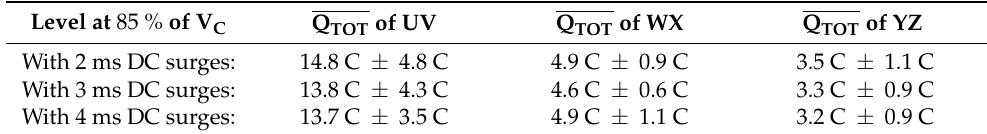
Table 10. Manufacturer durability comparison. Level at 85 % of V C Q TOT of UV Q TOT of WX Q TOT of YZ With 2 ms DC